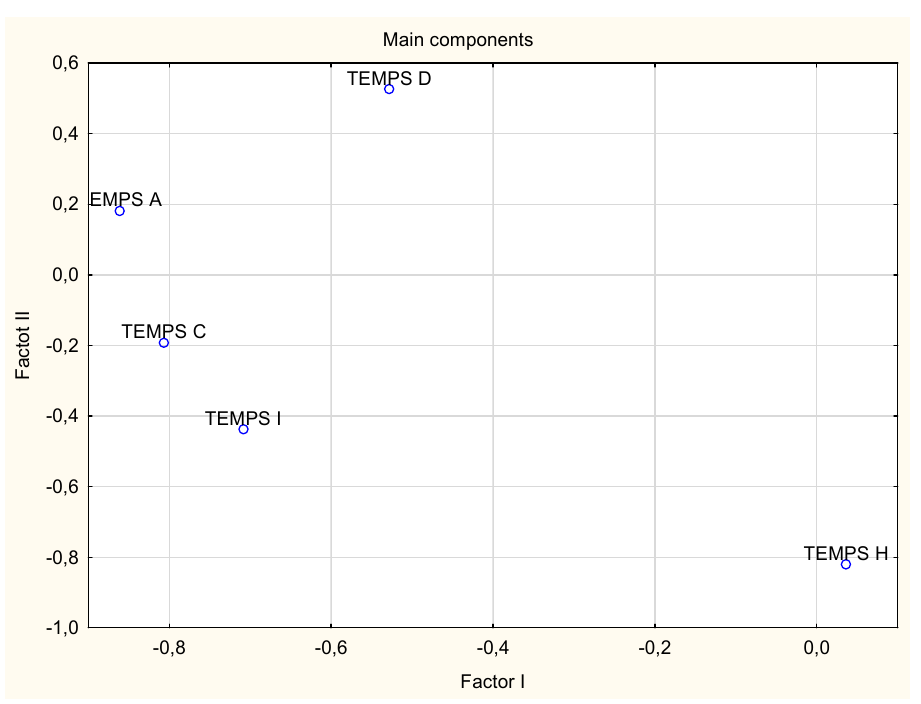
Figure 1. Spatial projection of the principal components of the TEMPS—A subscales.